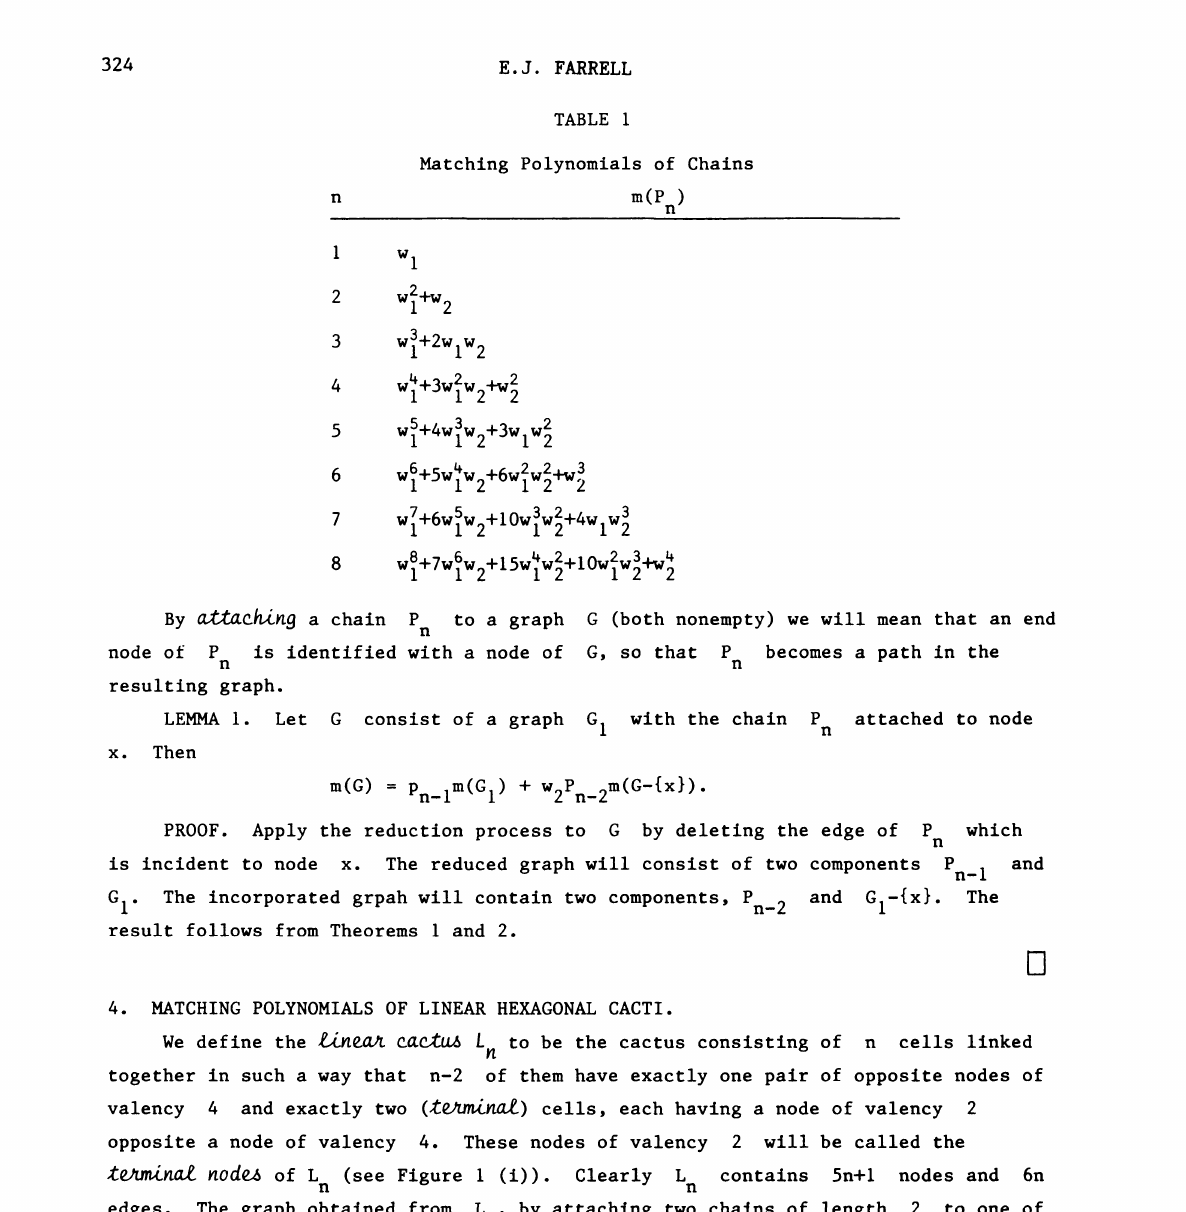
Matching Polynomials of Chains